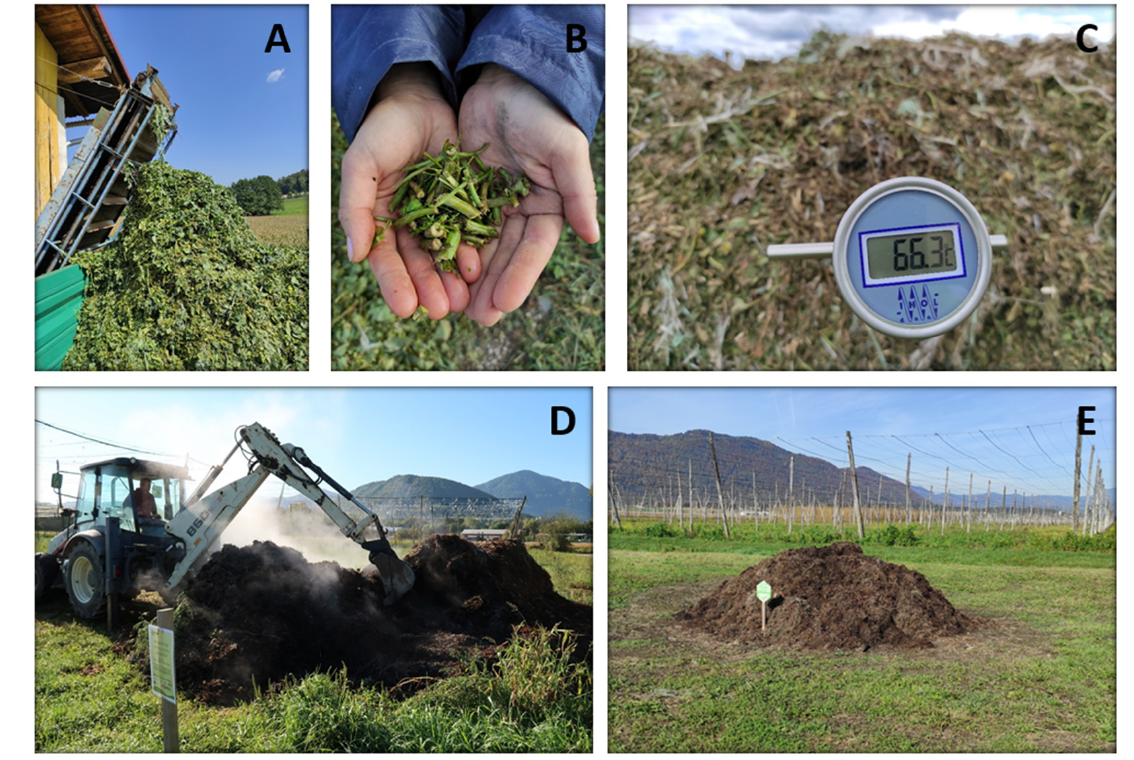
Figure 1. Experimental setup: ( A ) hop biomass waste; ( B ) particle size of hop stems; ( C ) temperature measurements in compost piles during composting; ( D ) compost turning; ( E ) form of a compost pile at hop farm.